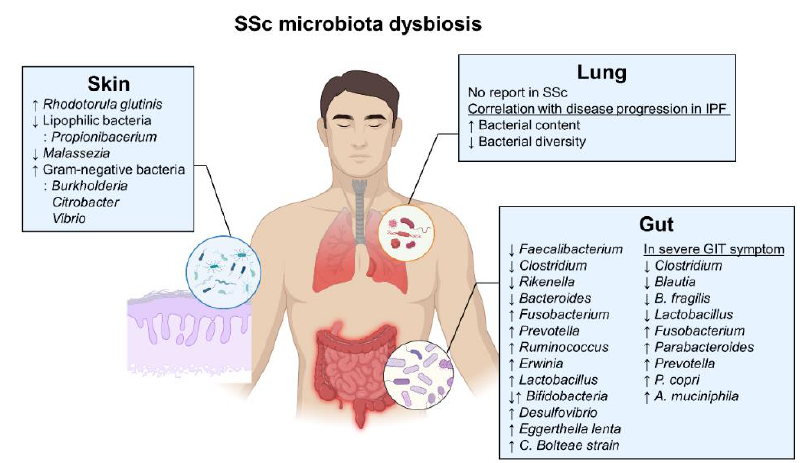
Figure 3. Microbiota alterations in the gut, skin, and lungs of patients with